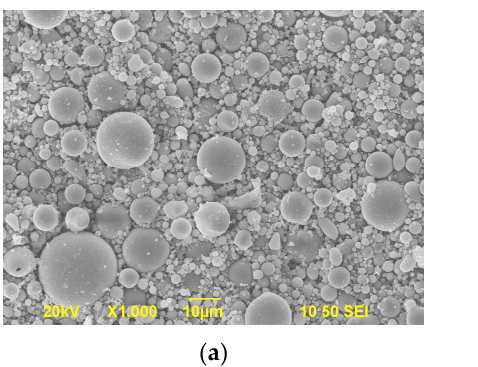
Figure 2. SEM images of GP-2h ( a ) and FA ( b ).